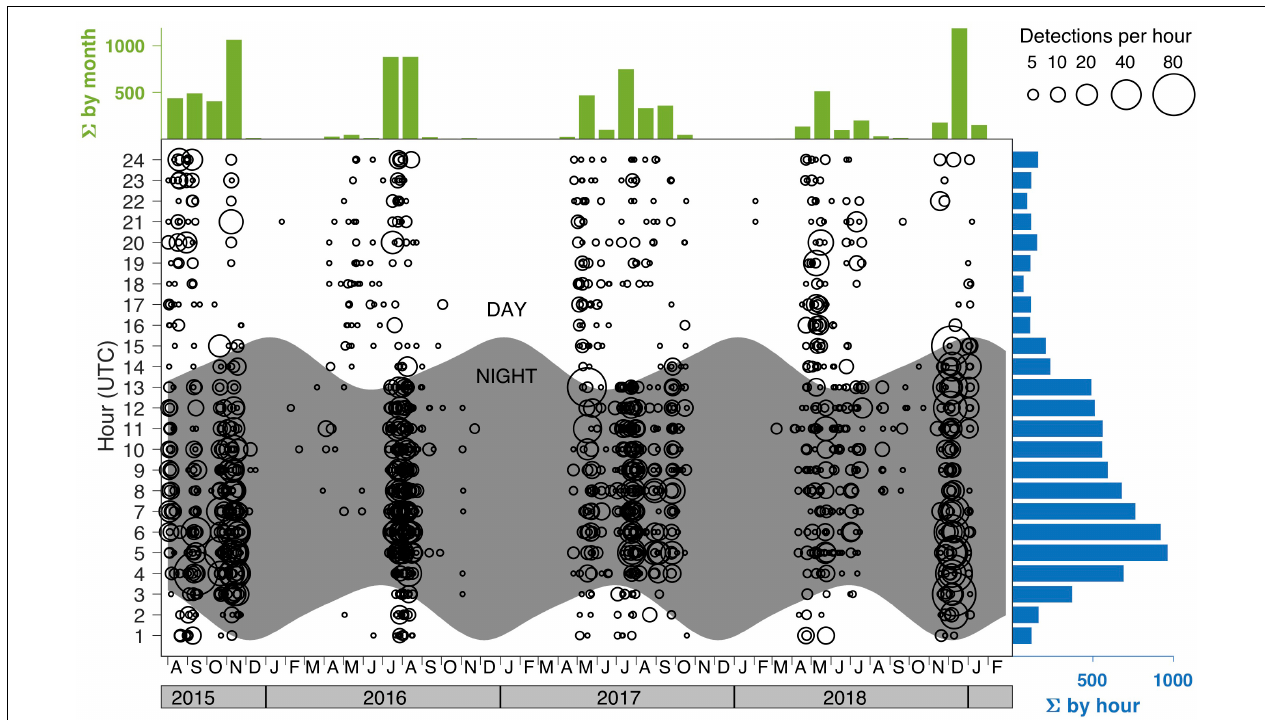
FIGURE 2 | True positive detections of seal bomb explosions in recordings from the MARS cabled observatory (https://www.mbari.org/at-sea/cabled-observatory/). Circle size represents the number of explosions per hour, for every hour of every day. Times are shown in UTC (Pacific Standard Time is UTC –8 h). Nighttime is shaded. Cumulative histograms are shown by hour and month. Figure reproduced with permission from Ryan